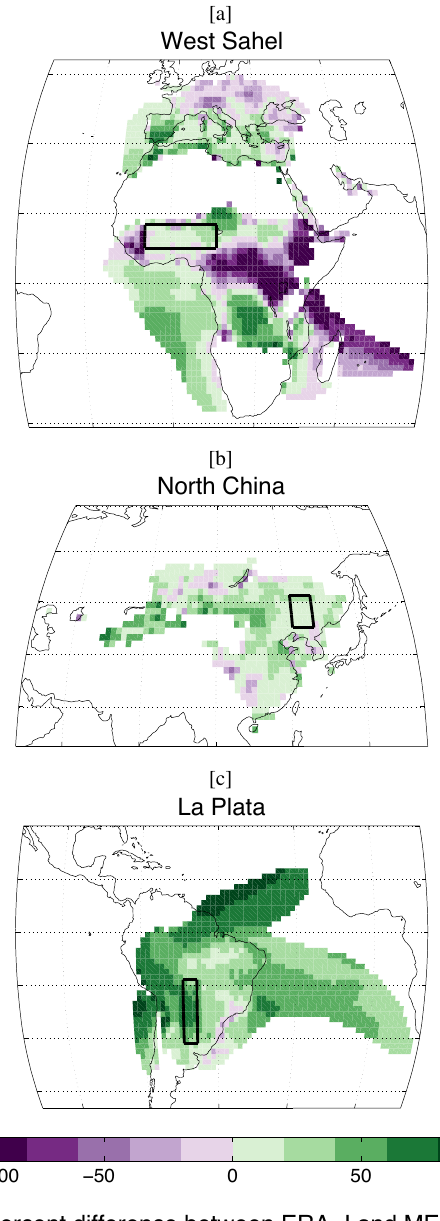
Figure 3. Difference between ERA-I and MERRA precipitation- sheds (see Fig. 2), as a fraction of the ERA-I value (see calcula- tion in Sect. 2.5.1), for the years 1980–2011. Green colors indicate Fig. 3. Difference between ERA-I and MERRA precipitationsheds (see Fig. ?? ), as a fraction of the ERA-I value (see calculation in Sec- where ERA-I source evaporation is larger, and purple colors indi- tion ?? ),fortheyears1980-2011.GreencolorsindicatewhereERA-Isourceevaporationislarger,andpurplecolorsindicatewhereMERRA source evaporation is larger. cate where MERRA source evaporation is